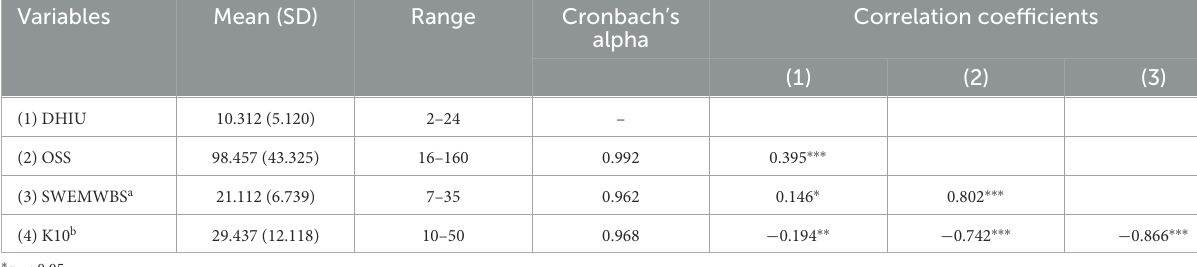
TABLE 1 Descriptive statistics, internal consistency scores, and correlational analysis among key variables ( N =